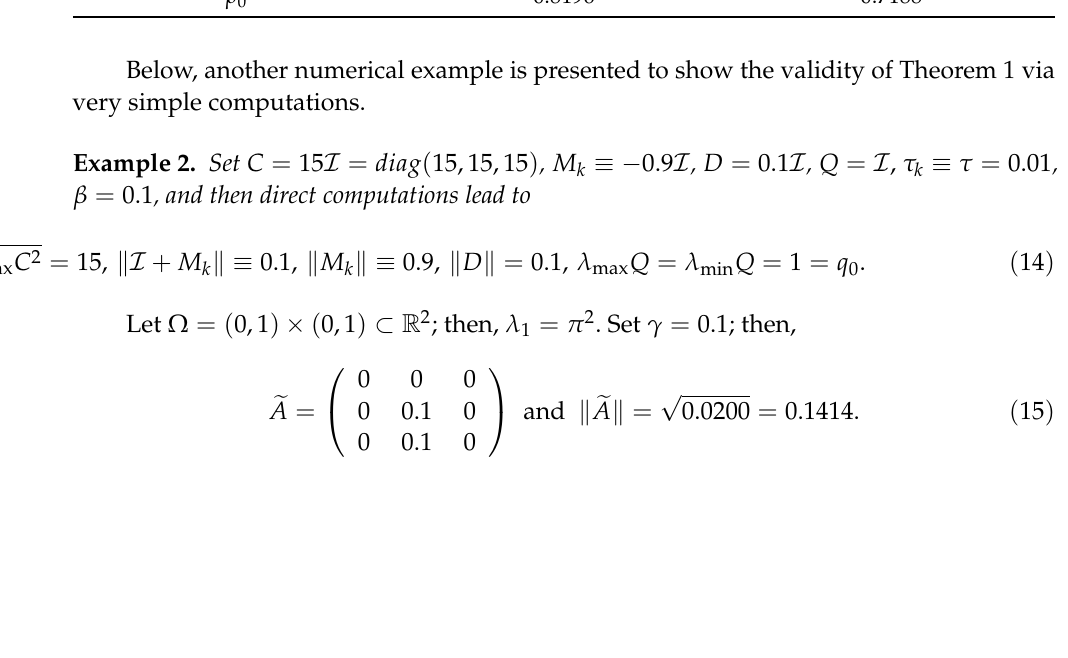
Table 3. Comparison of the influence of different time delays of the impulse effect when other data are unchanged. Case 1: τ k = 0 . 01 Case 2: τ k = 0 . 001 ρ 0.1 0.1 M k − 0.7 I − 0.7 I ρ 0 0.8196